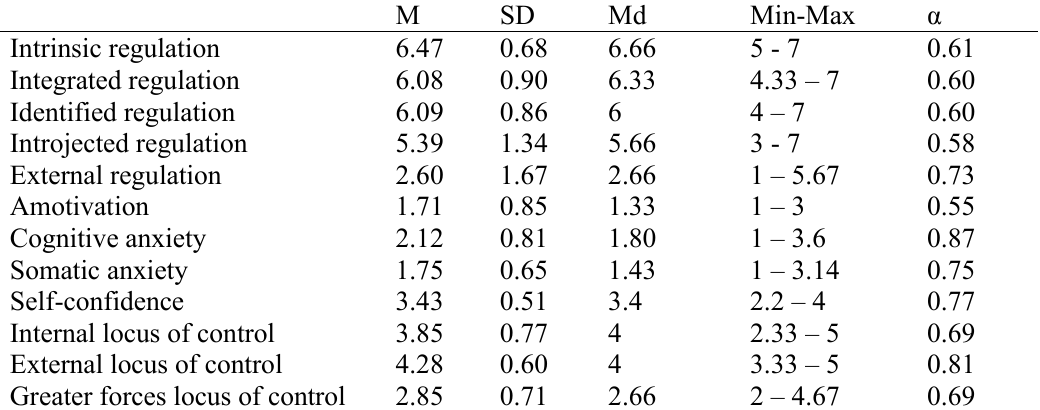
Table 1. Description analysis and internal